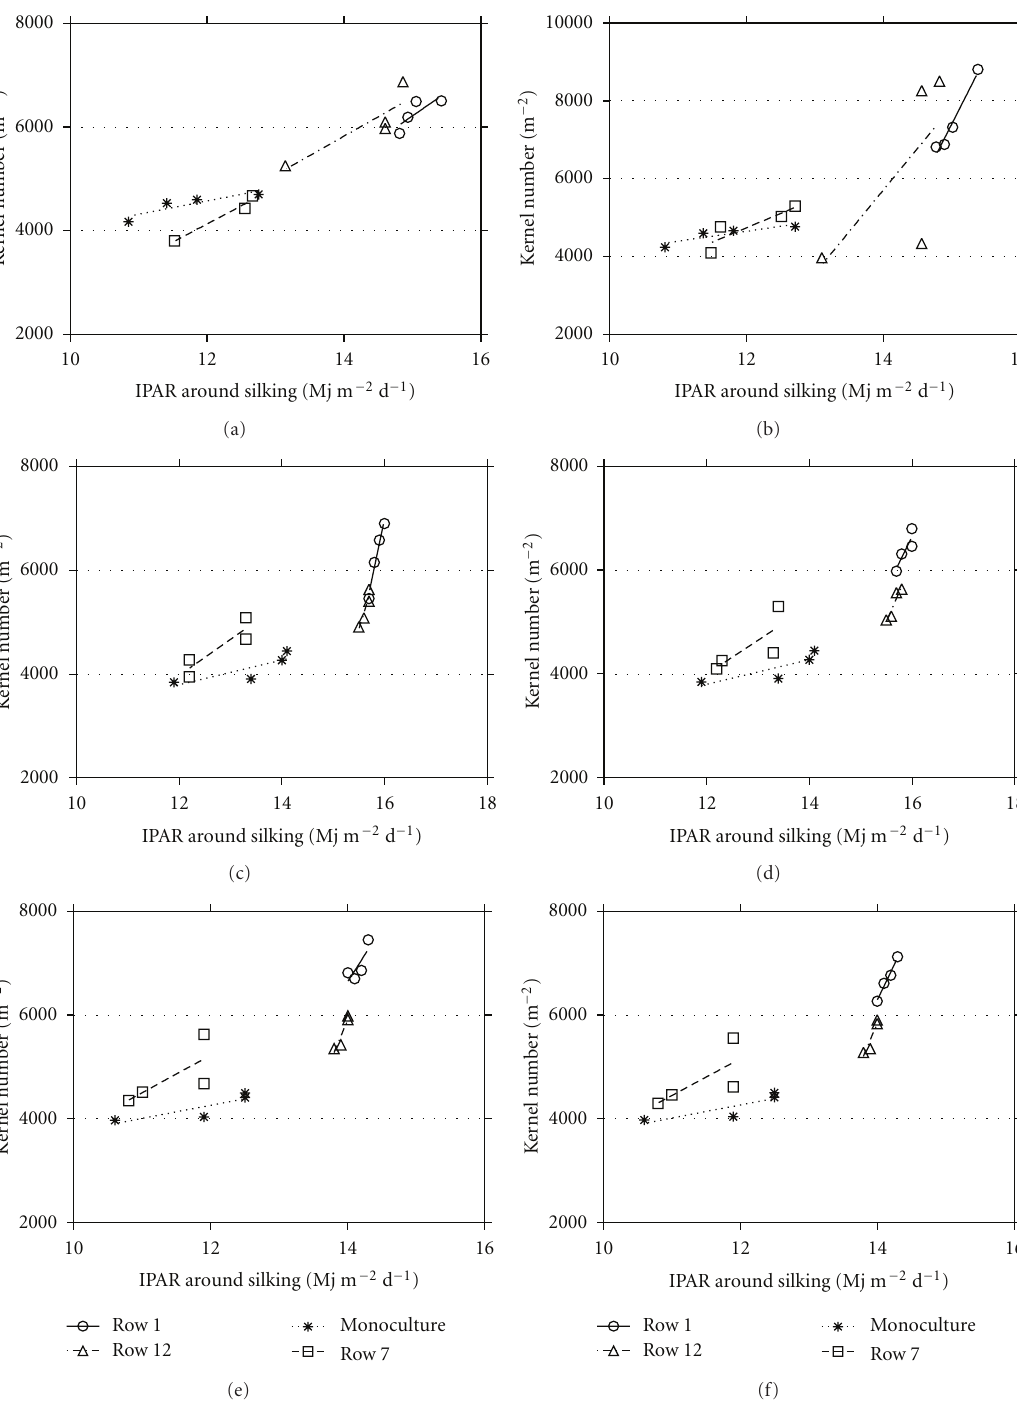
showed the highest CGR during the critical period,